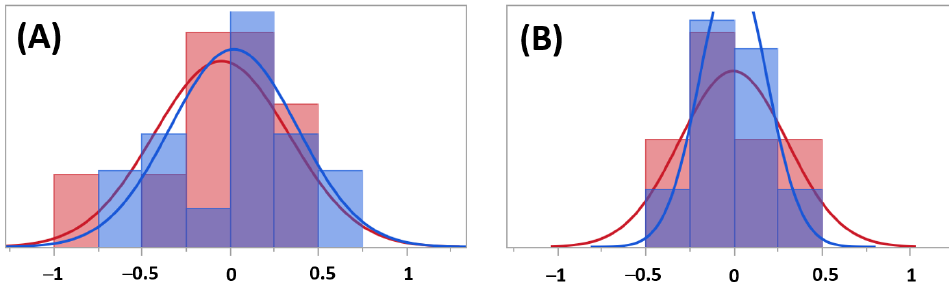
Figure 15. ( A ) Actual vs. predicted plot for the developed model and ( B ) stratified on test sets.